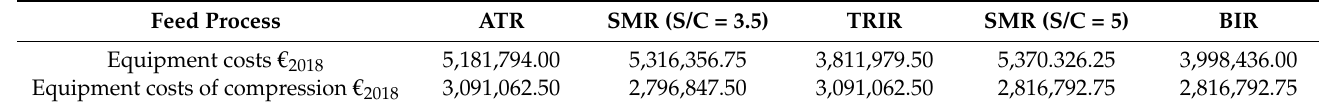
Table 12. Equipment costs of Selexol process and CO 2 compressor to 150 bar.